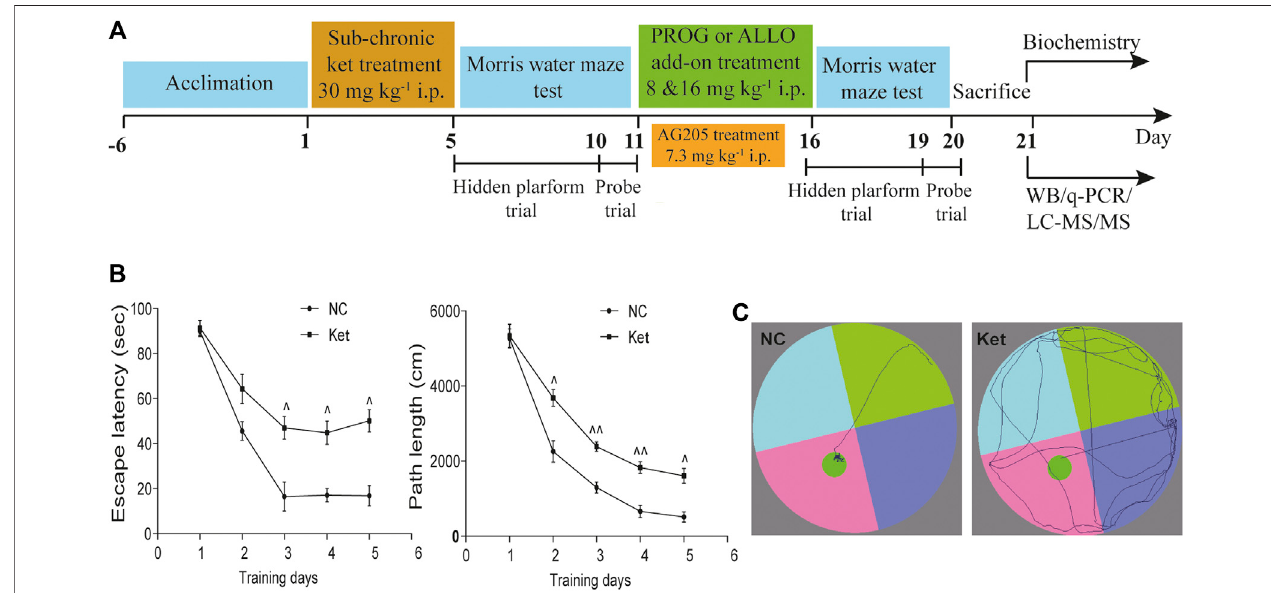
FIGURE 1 | Cognitive performance in the hidden platform trials of MWM test after ketamine exposure. (A) A diagram of the time course illustrating when the procedures took place. (B) Learning ability manifested as escape latency and path length of ketamine-exposed rats ( n (cid:2) 42) vs. NC ( n (cid:2) 7). (C) The swimming traces of the rats are illustrated (NC vs. Ket). ^ p < 0.05, ^^ p < 0.01, and ^^^ p < 0.001 for Ket vs.